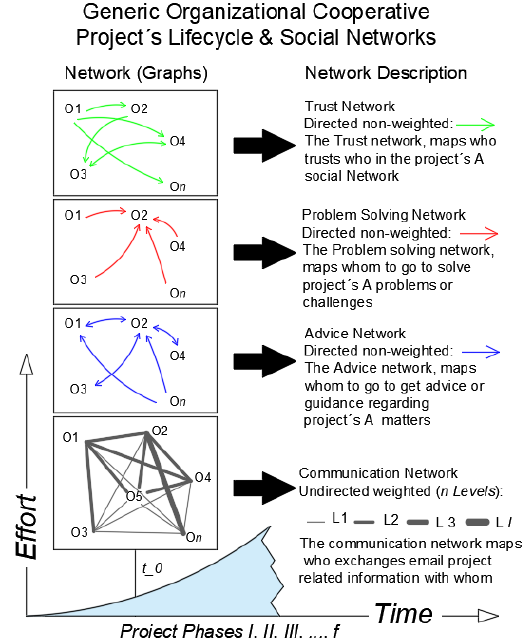
Figure 2. Proposed model development and implementation